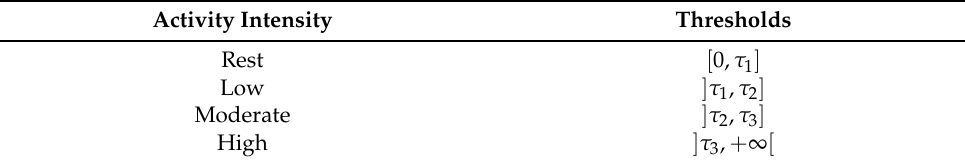
Table 1. Activity intensity and their corresponding ranges.